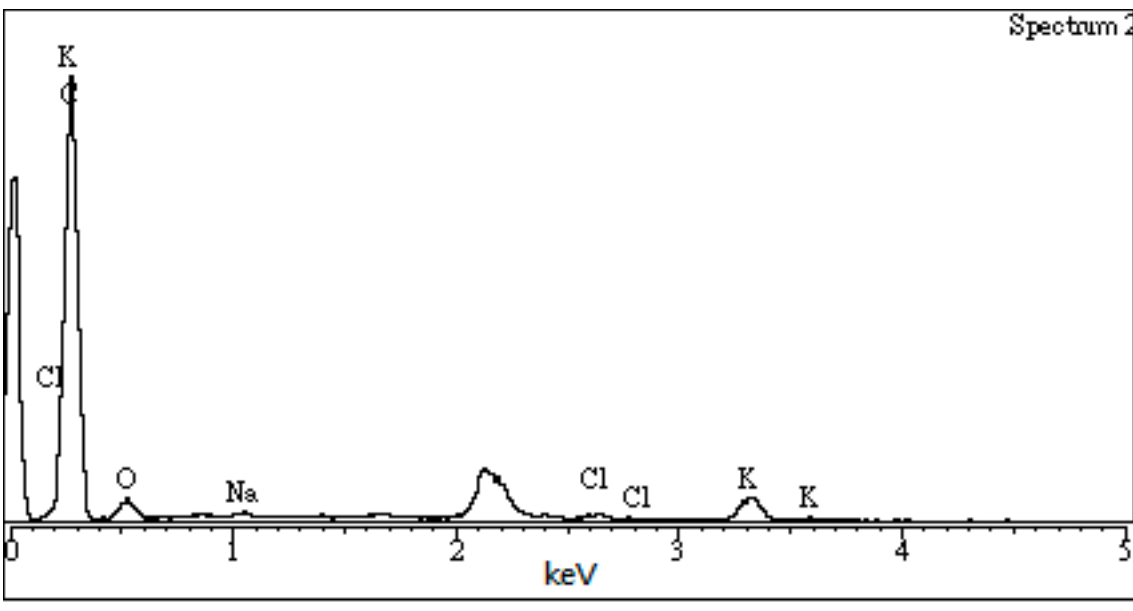
Figure 4. EDS spectra of resulting AC (WCH-AC) and its relative compositions of elements detected.